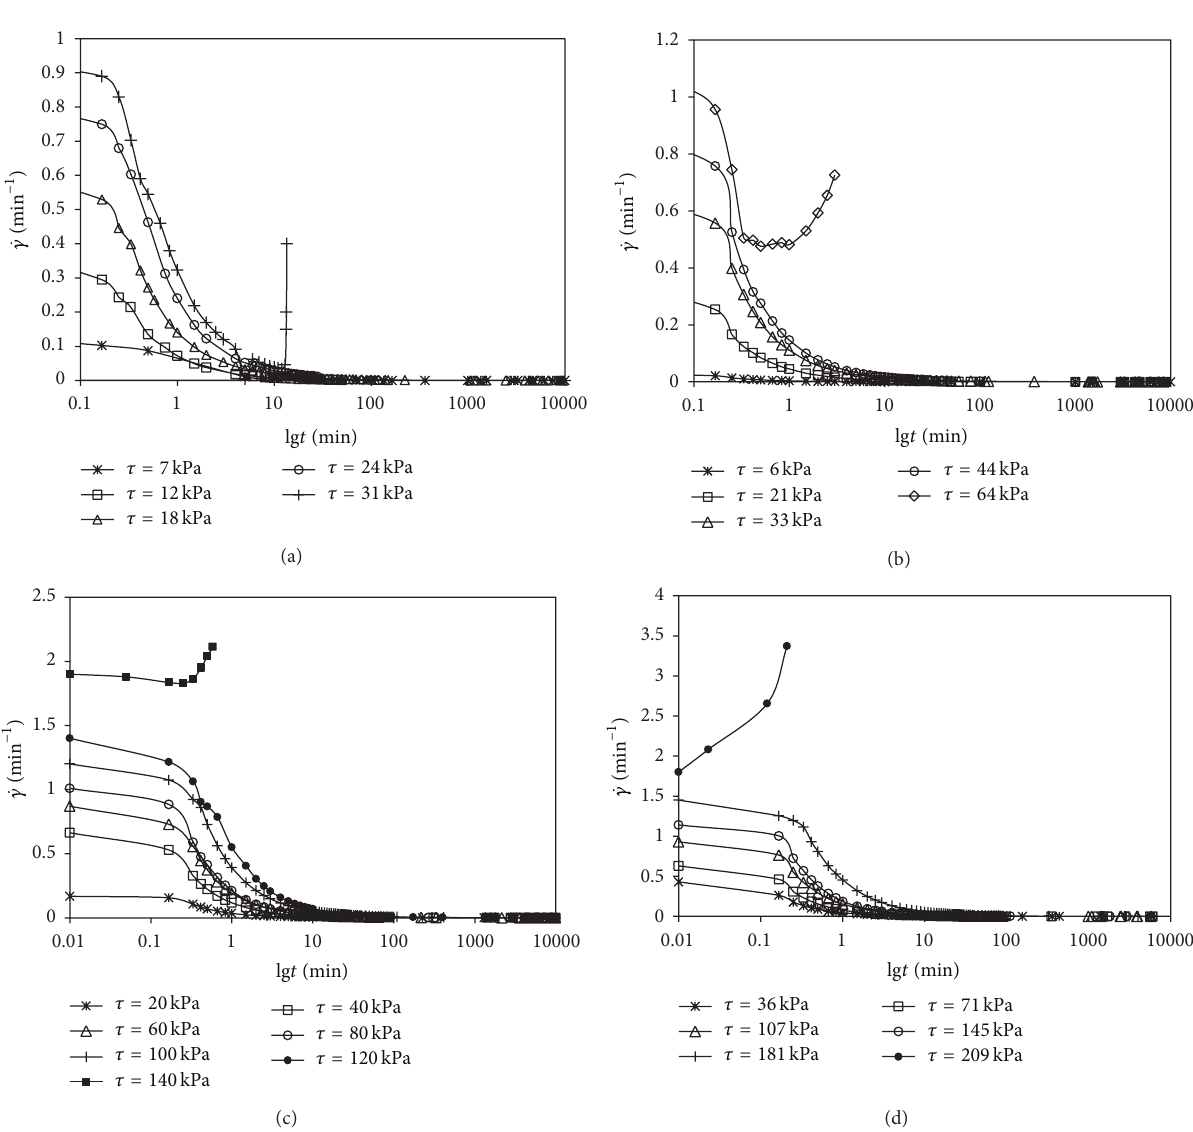
is greater than 𝜏 𝑓 under the same consolidation pressure, and 𝜏 𝑐 /𝜏 𝑓 grows bigger with the increasing of consolidation